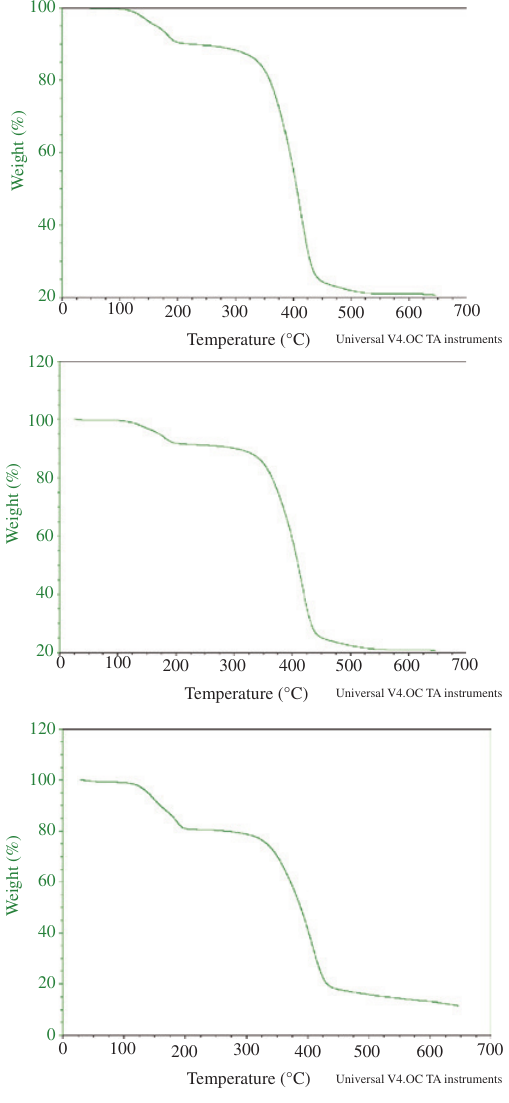
Figure 4: Thermograms of neat epoxy and epoxy composites: (A) thermogram of EPNC; (B) thermogram of EPMC; and (C) thermogram of NEP.